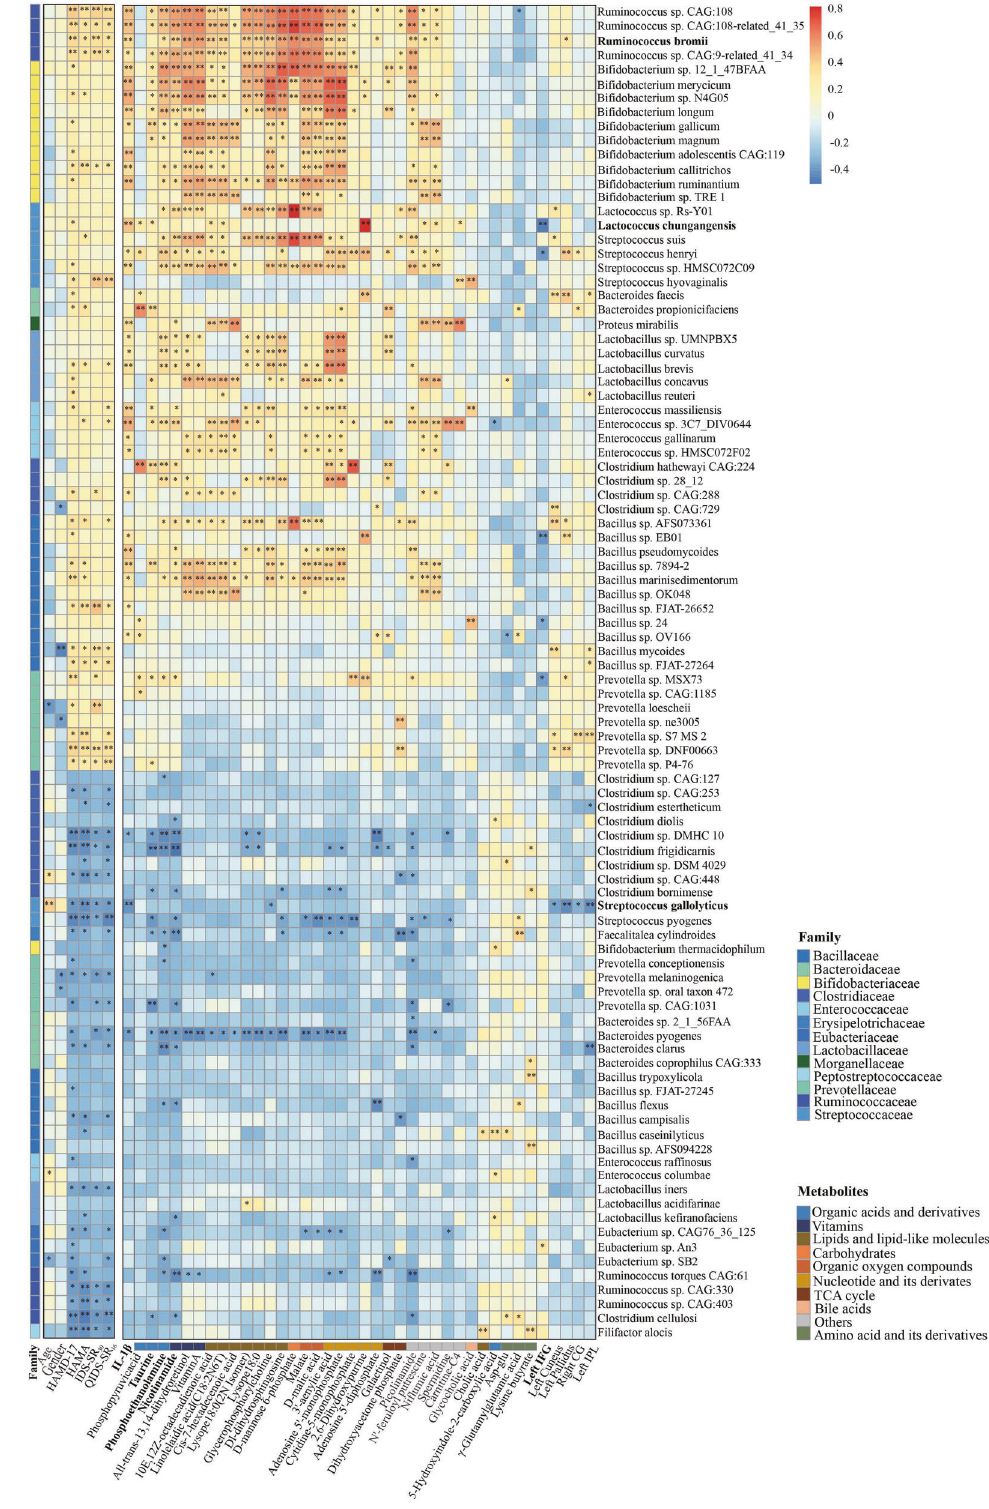
Fig. 5 Correlations between gut microbiome and metabolites, IL-1 β , GMV, clinical characteristics of MDD. Heat map of the Pearson correlation coef fi cient of 94 species of the gut microbiome, IL-1 β , 34 metabolites, and 5 brain regions as well as 6 clinical indexes. The X-axis is clinical indexes (including age, gender, and clinical scales), IL-1 β , metabolites (consisted mainly of organic acids and derivatives, vitamins, lipids, and lipid-like molecules, etc.), and GMV of brain regions, in order. Y-axis is the 94 species of the gut microbiome. Red squares indicate positive associations; while blue squares indicate negative associations. The statistical signi fi cance was denoted on the squares (* p < 0.05, ** p < 0.01). HAMD-17 The 17-item Hamilton Depression scale, HAMA Hamilton Anxiety Scale, IDS-SR 30 30-item Inventory of Depressive Symptoms-Self Report, QIDS-SR 16 16-item Quick Inventory of Depressive Symptomatology-Self Report, IFG Inferior frontal gyrus, IPL Inferior parietal lobe, CG Cingulate